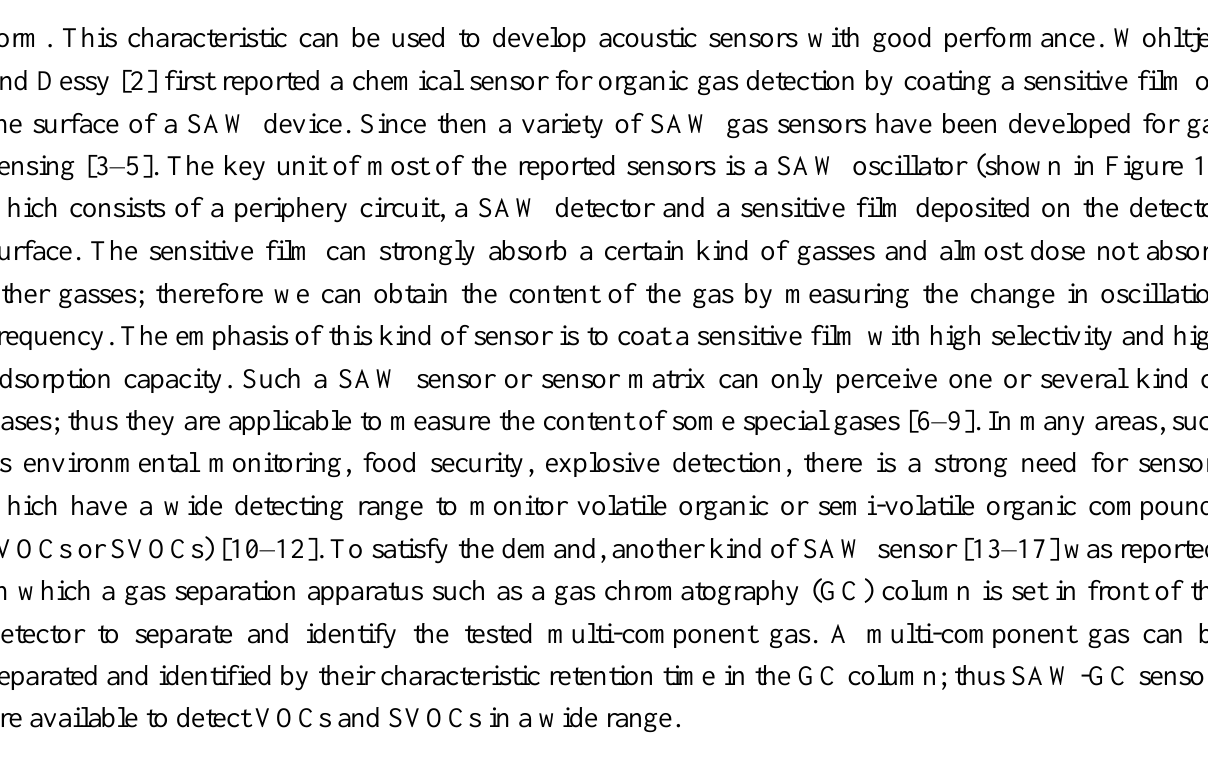
Figure 1. Schematic of SAW gas